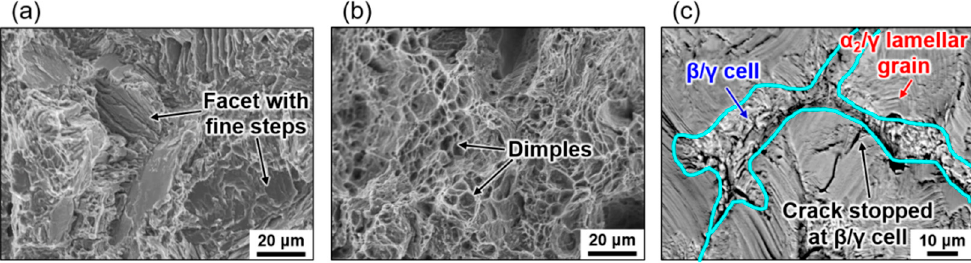
Figure 8. Typical SEM fractographs ( a , b ) and side view SEM image ( c ) of 0.1AG ( a ) and 0.5AG ( b , c ) after tensile deformation to fracture at 1023 K.